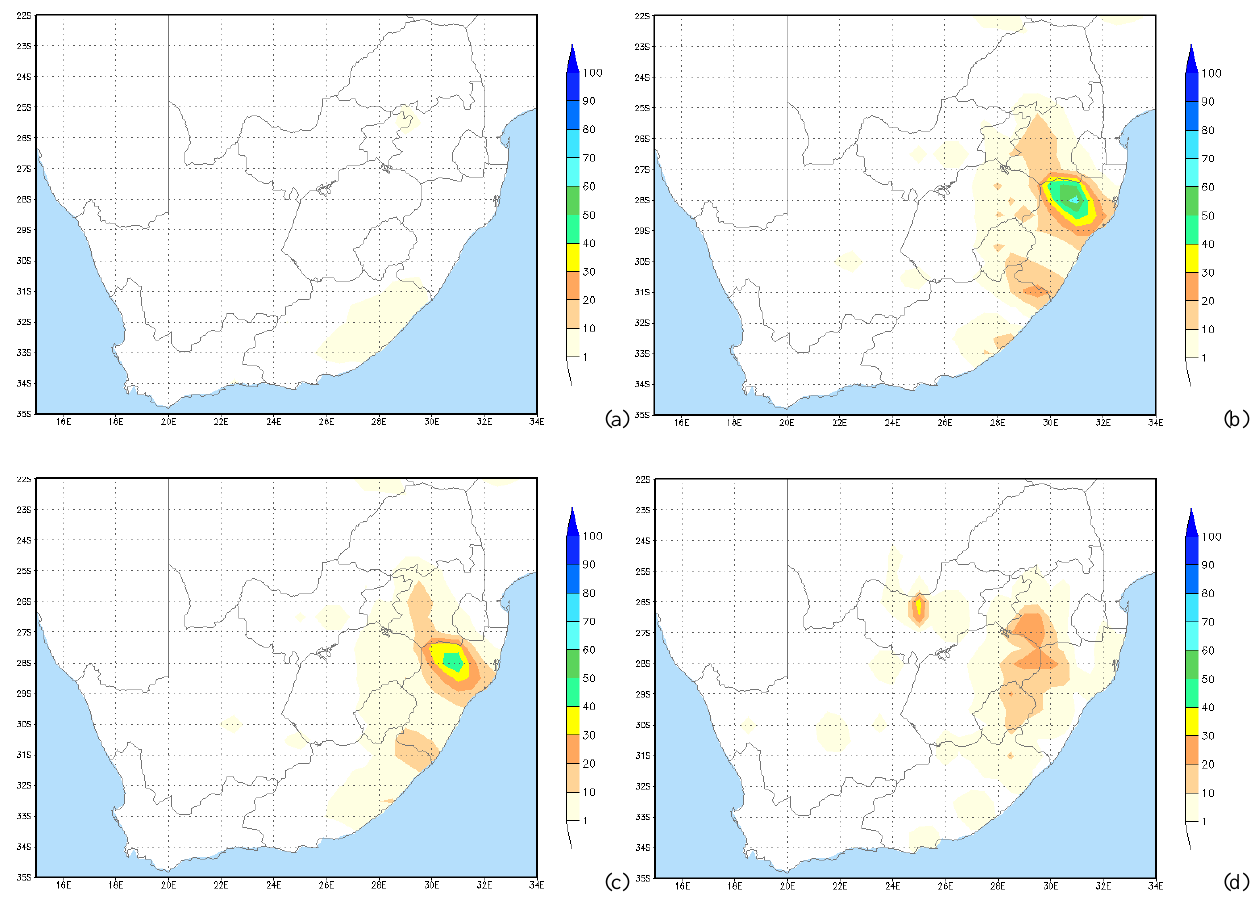
Fig. 11. UMS precipitation total for 24h (a) , HE precipitation total for 24h (b) , COMB precipitation total for 24h (c) and the total rainfall as measured by the rain gauges (d) for 28 January 2008.